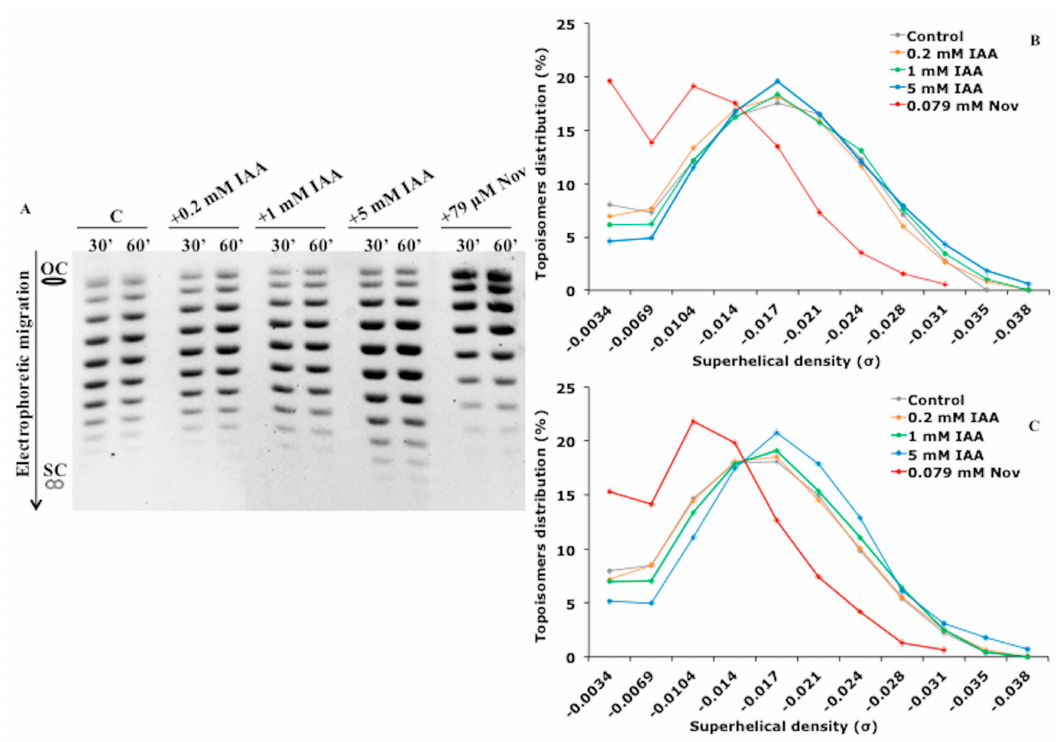
Figure 2. E ff ect of IAA on DNA topology in Escherichia coli cells. ( A ) Analysis of the relative topoisomers distribution of the reporter plasmid pBlueScript (pBS). The pBS plasmid was purified from E. coli BL21 control cells and the ones treated for 30 and 60 min with IAA (0.2, 1, and 5 mM) or novobiocin (79 µ M) and separated by electrophoresis in 0.7% agarose gels containing 1 µ g mL − 1 chloroquine. ( B and C ) Topoisomers’ distribution calculated as a percentage of topoisomers with specific superhelical density versus total DNA in each condition after 30 and 60 min of treatment, respectively. The topological state of each topoisomer is expressed as the specific superhelical density ( σ ). OC, open-circular DNA; SC, supercoiled DNA. The electrophoretic mobility reported in Figure 2A is a representative image of three biological replicates. Nov,